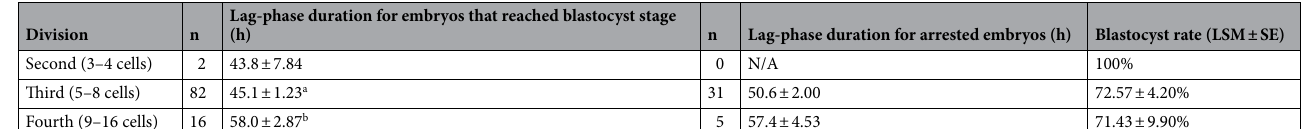
displayed a lower percentage of ruffling membrane (4.2%) than slow cleavers (22.6%; p < 0.0001). Experiment 2.